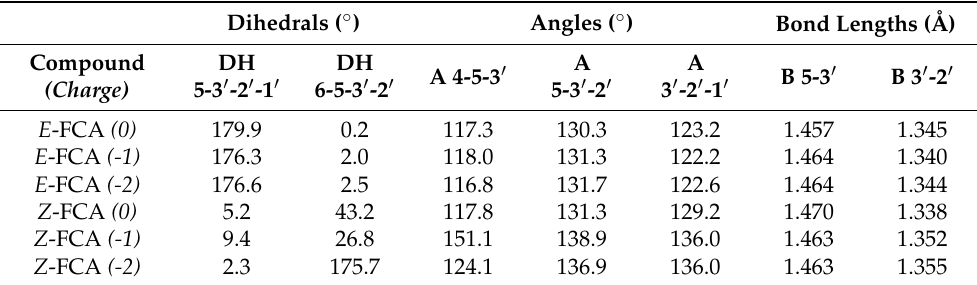
Table 2. The values of dihedrals, angles, and bond lengths calculated for ( Z/E )-FCAs.